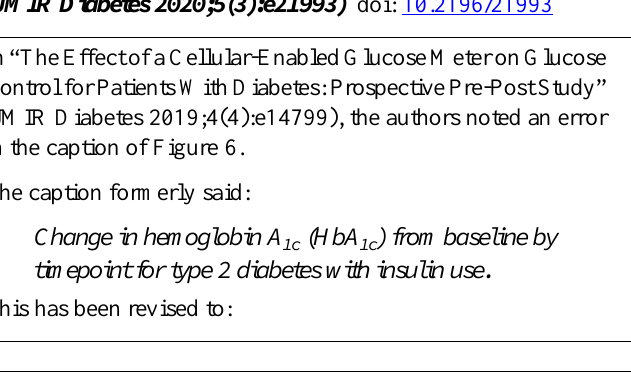
Figure Correction: The Effect of a Cellular-Enabled Glucose Meter on Glucose Control for Patients With Diabetes: Prospective Pre-Post